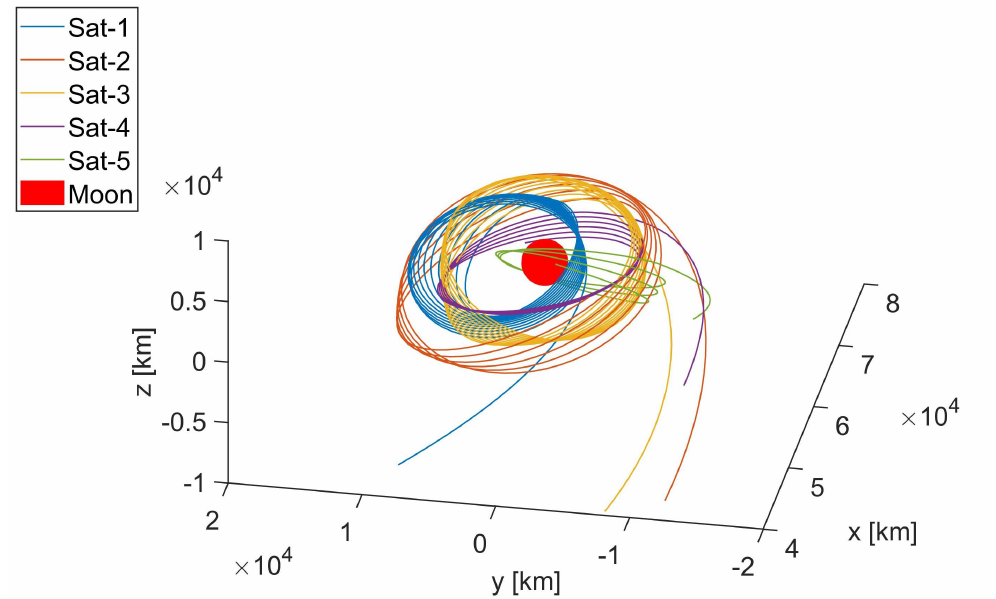
Figure 4. Satellites trajectories during Phase 2: detail of the lunar orbits in the rotating